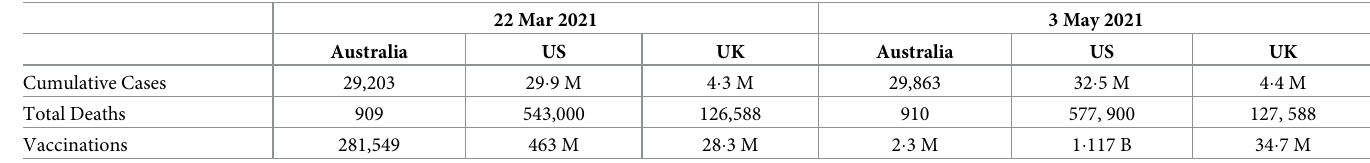
Table 1. Comparison of cumulative cases, deaths and vaccinations between Australia, US and UK